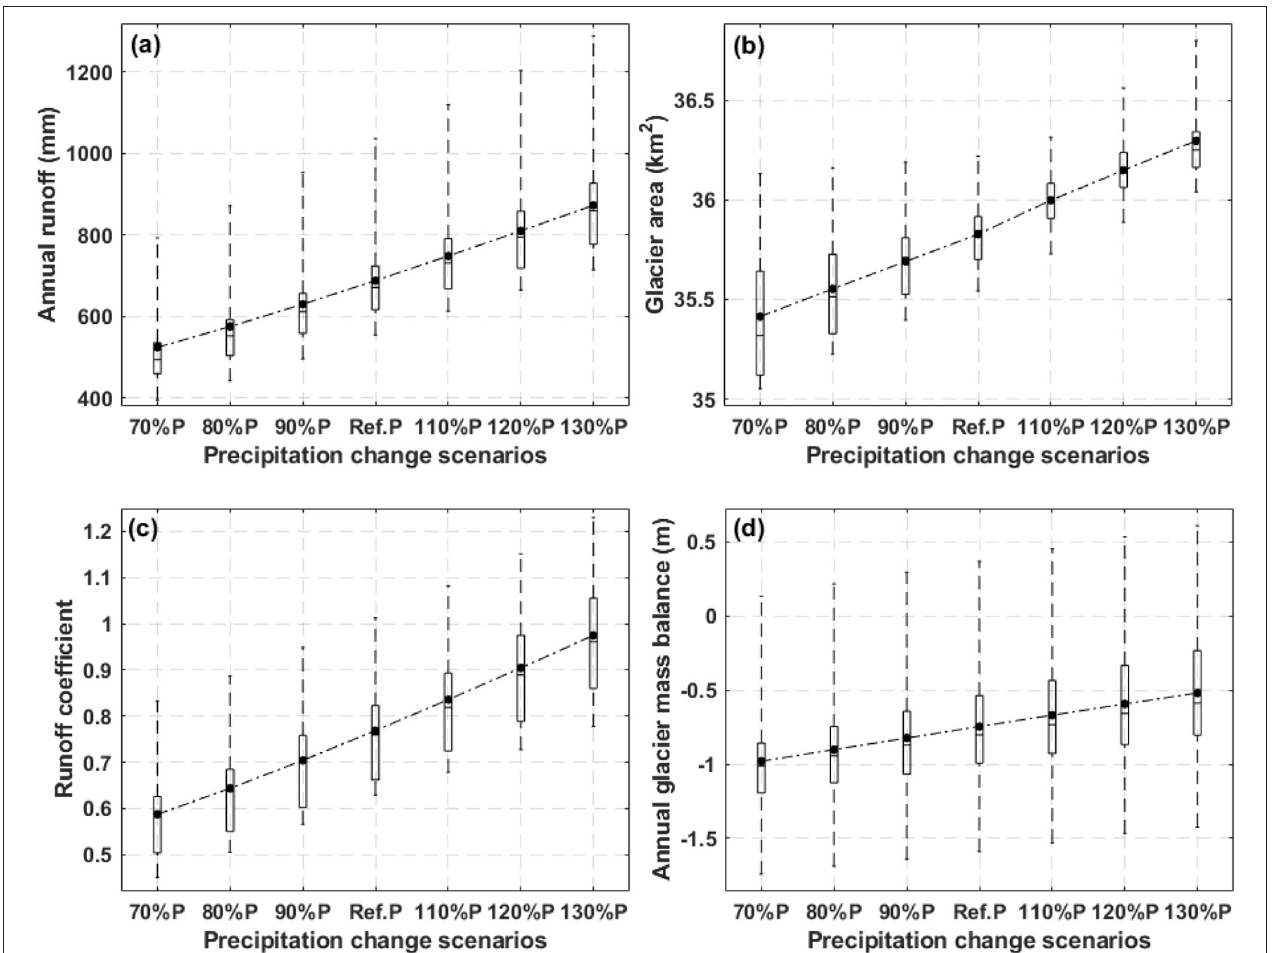
FIGURE 6 | Sensitivities of hydrological variables to precipitation changes. Boxplots indicate the inter-annual variabilities of hydrological variables during the 20-year modeling period, and dots indicate mean values during the modeling period. (a) for the sensitivity of annual runoff, (b) for glacier area, (c) for runoff coefficient, and (d) for annual glacier mass